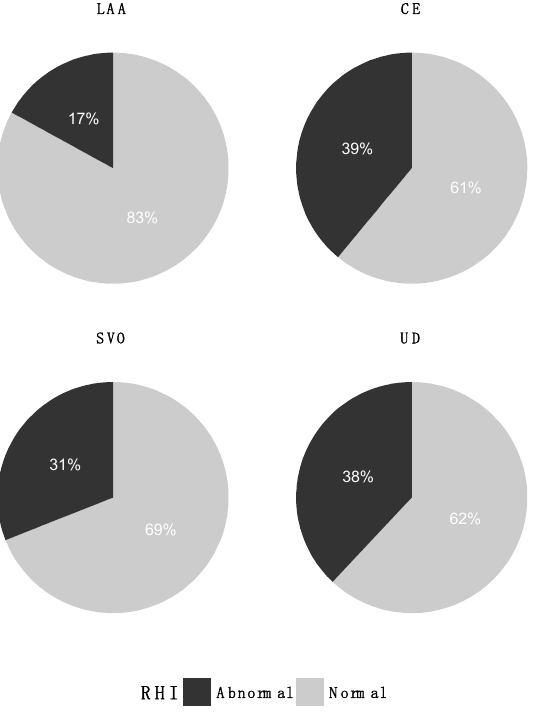
Figure 3. Distribution of abnormal RHI (<1.67) across TOAST groups. CE: cardioembolism; LAA: large artery atherosclerosis; SVO: small vessel occlusion; UD: undetermined etiology.